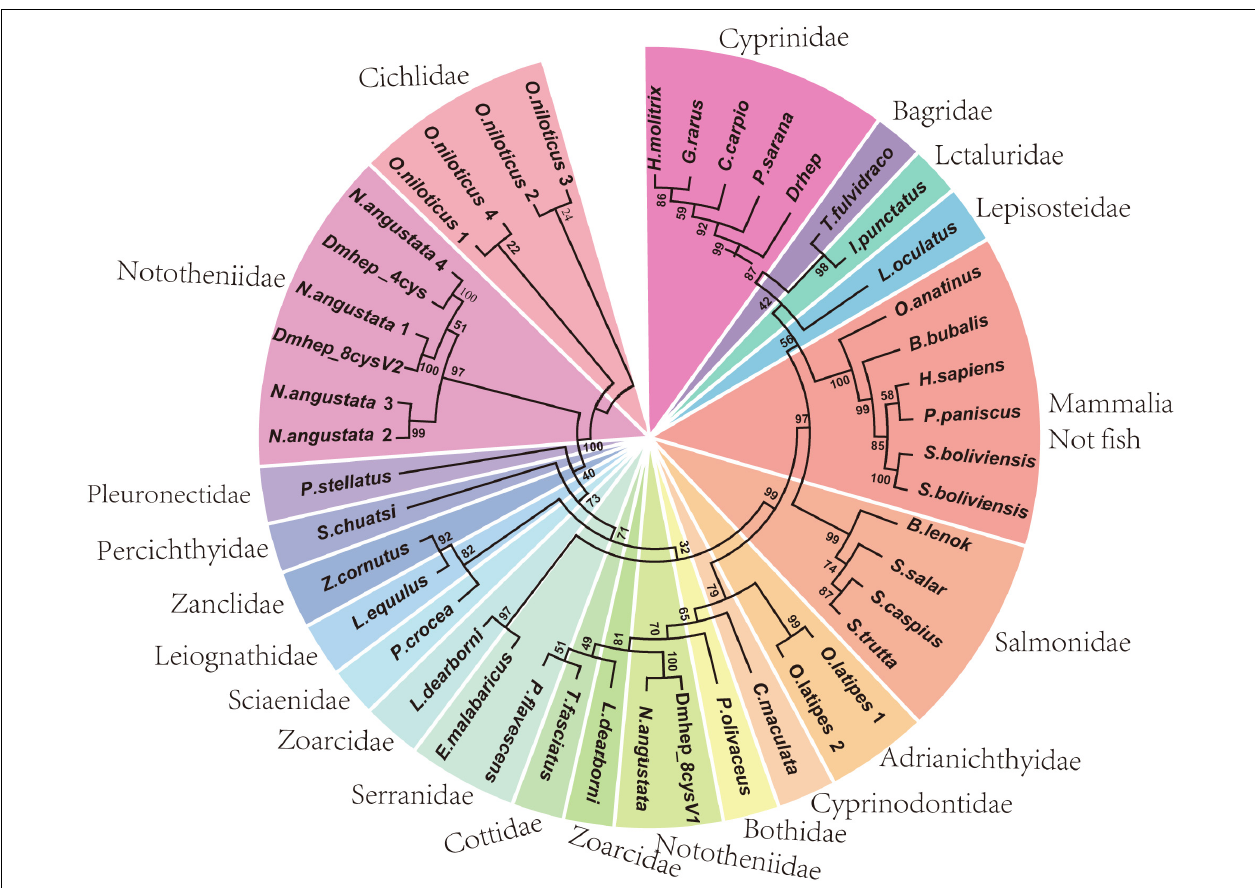
FIGURE 1 | Phylogenetic analysis of hepcidins from teleost and other vertebrates. The phylogenetic trees constructed by neighborhood join method in MEGA 7.0. The numbers given are frequency (%) of a given branch in 1,000 bootstrap replications.